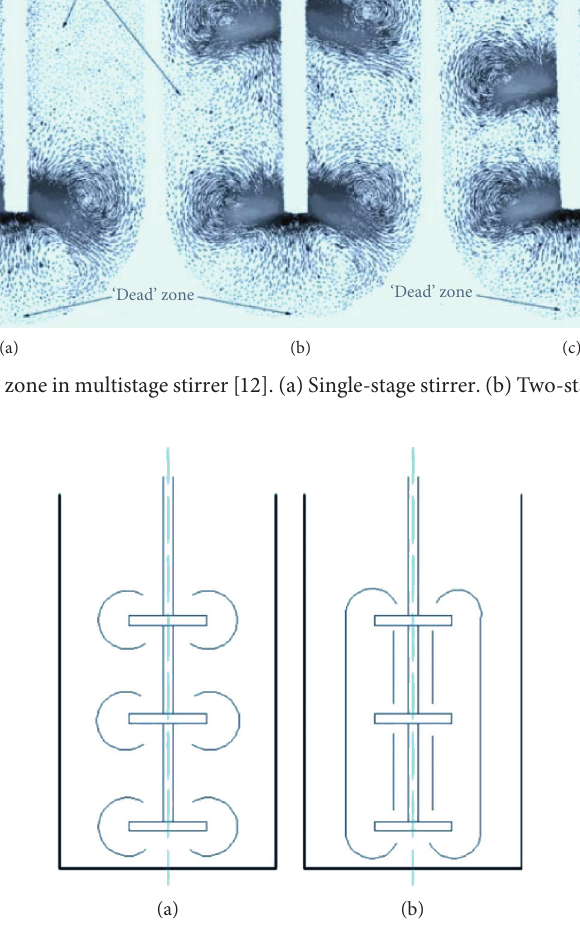
Figure 9: Two different circulation profiles in the vessel with the multistage stirrer [12].